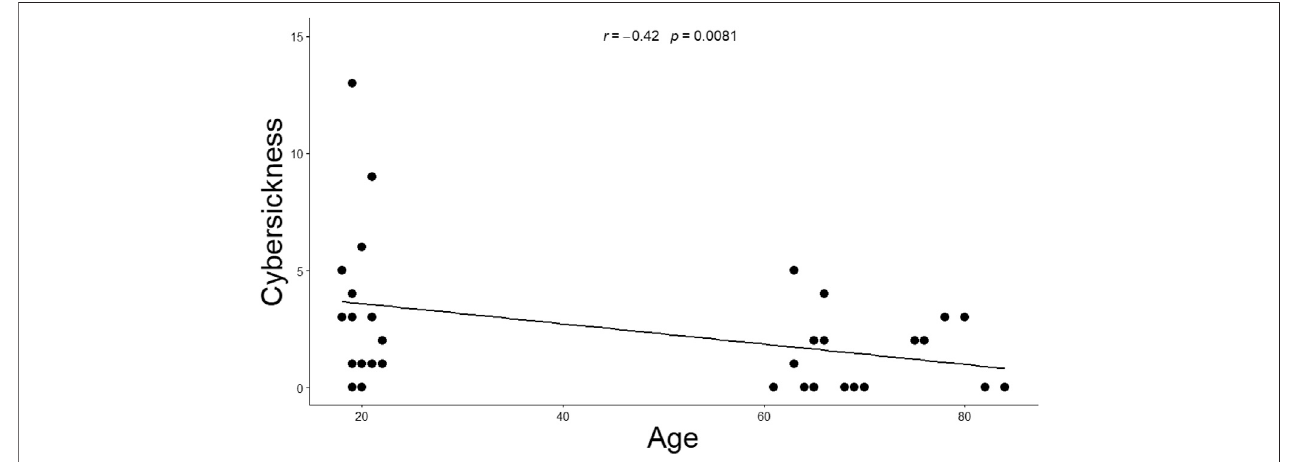
FIGURE 5 | Scatter plot depicting the relationship between cybersickness and age. As one younger adult did not report their age, N (cid:1) 19 younger adults, 20 older adults.